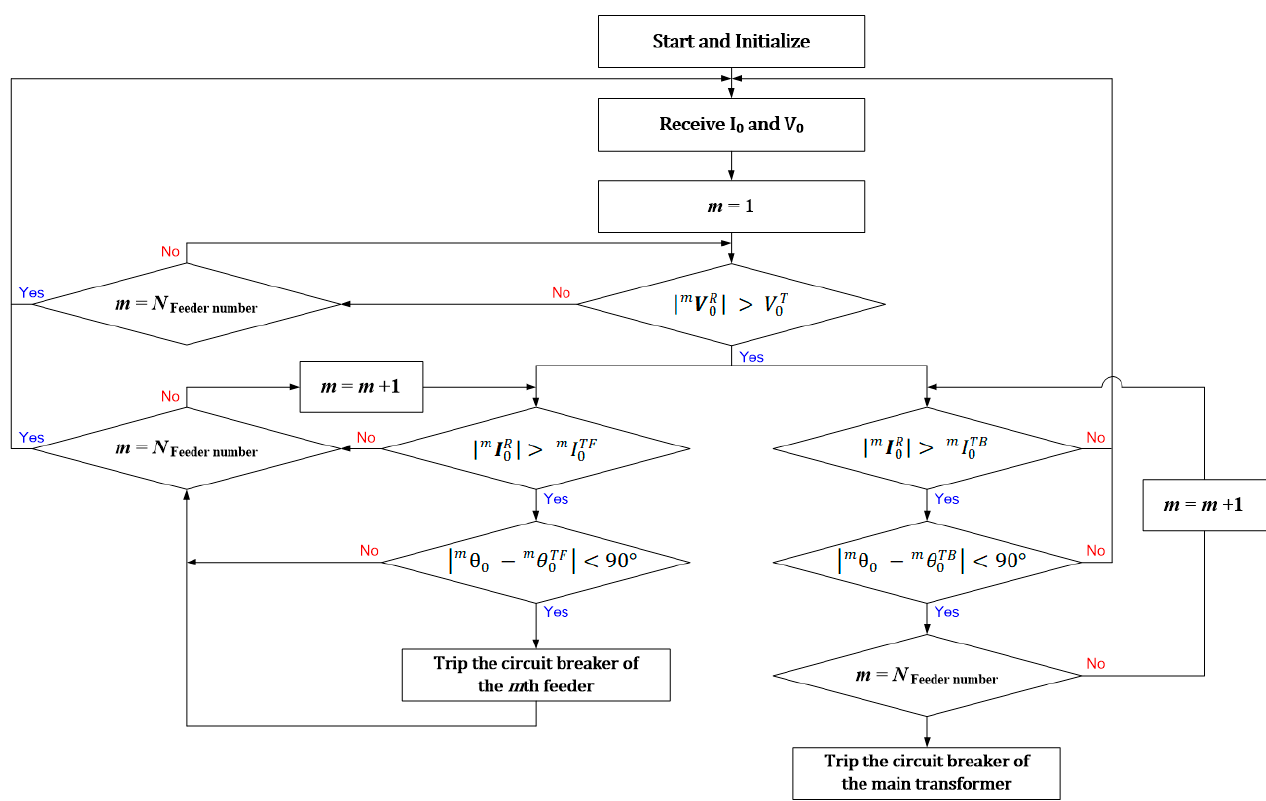
Figure 8. Flowchart of the centralized protection scheme to prevent SLG faults.